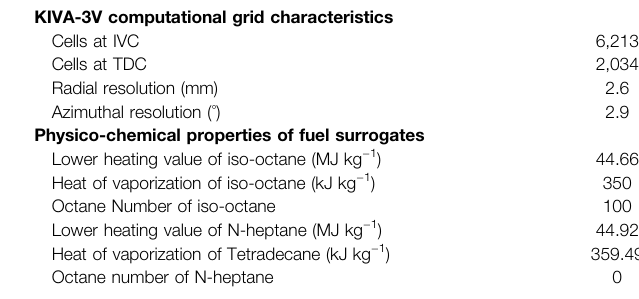
TABLE 3 | Computational grid features/characteristics and physico-chemical properties of fuel surrogates used in the KIVA-3V CFD